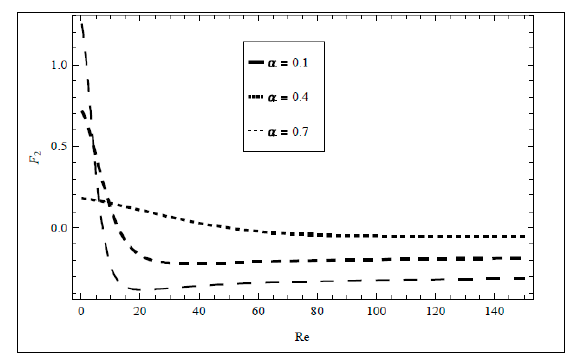
Figure 13. Effect of α on F 2 along Re at K = 0.1.